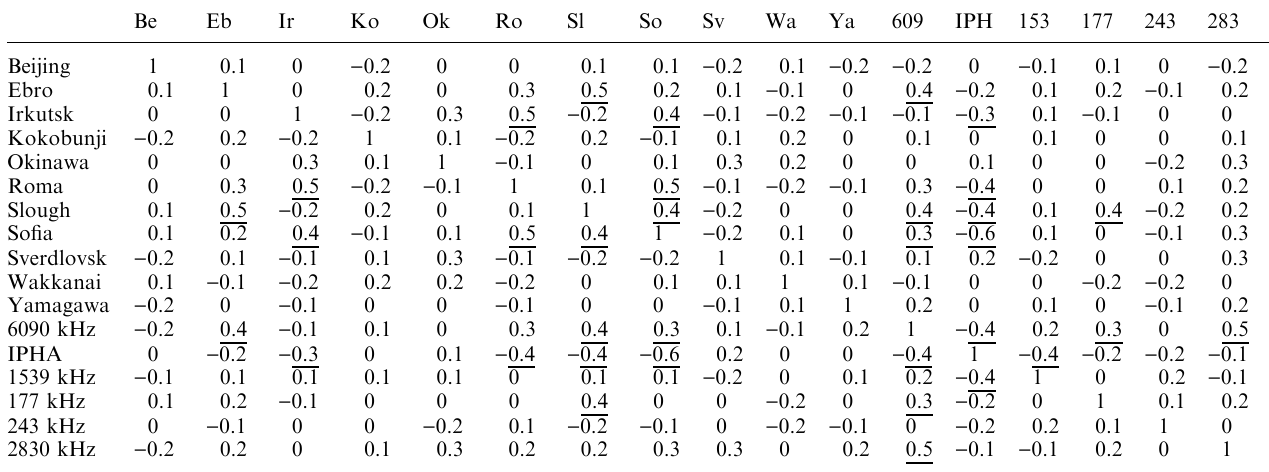
Table 5. Matrix of correlation coe(cid:129)cients for all analyzed iono- spheric parameters, October–November 1994. Correlation coe(cid:129)- cients significant at the 0.01 level are underlined.